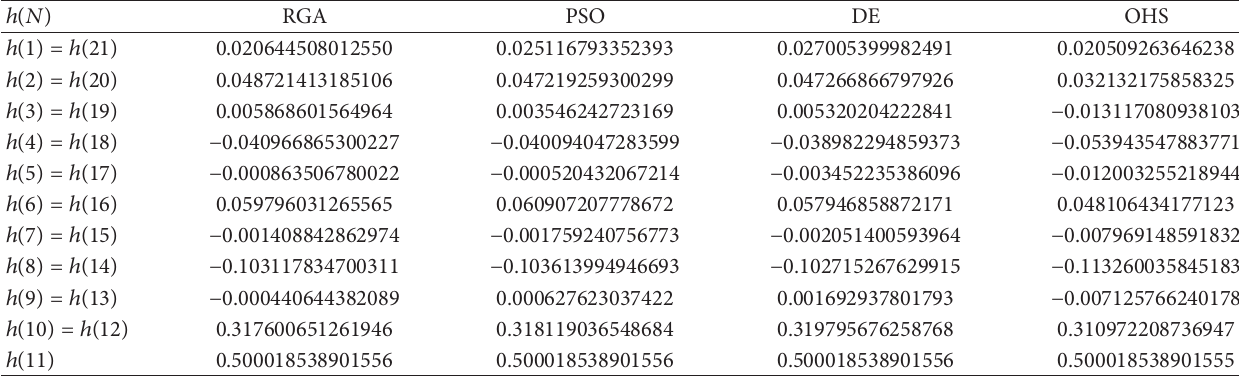
Table 2: Optimized coefficients of the FIR LP filter of order 20.